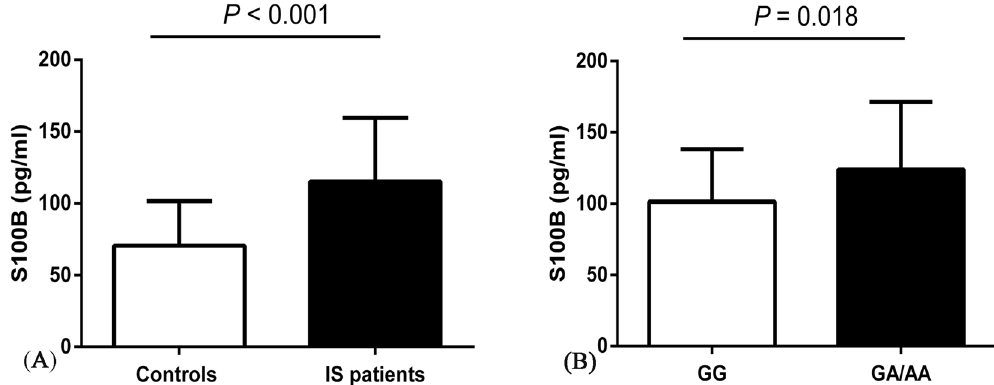
Figure 1. ELISA detection of serum S100B levels. (A) There were significant differences in the levels of serum S100B between IS patients [(115.03 ± 44.42) pg/mL; n = 44] and controls [(70.53 ± 30.98) pg/mL; n = 44], (P < 0.001). (B) Increased levels of serum S100B in IS patients carrying the rs9722 GA/AA genotypes [(123.98 ± 47.42) pg/mL; n = 52] compared with those carrying the rs9722 GG genotype [(101.33 ± 36.98) pg/ mL; n = 36)], ( P = 0.018). Data are presented as the mean ± standard